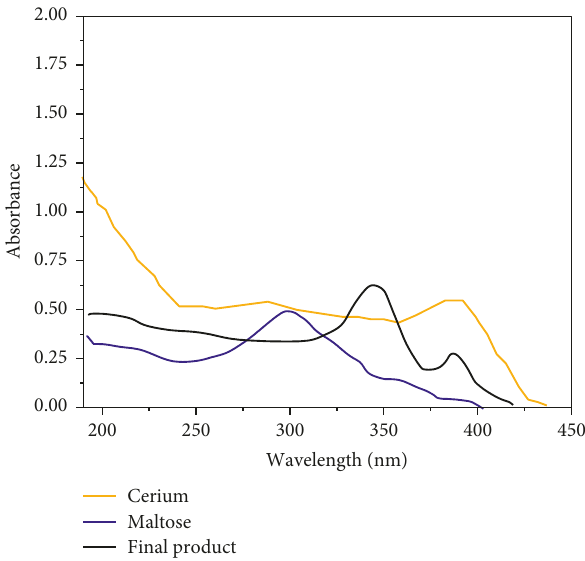
Figure 1: Ultra violet-visible spectra of the acidic solution of [maltose] � 6.0 × 10 − 3 mol dm − 3 [Ce (IV)] � 6.0 × 10 − 4 mol dm − 3 dissolved in 0.40mol dm − 3 [H 2 SO 4 ]. The expected product in re- action medium in the presence of excess [Ce